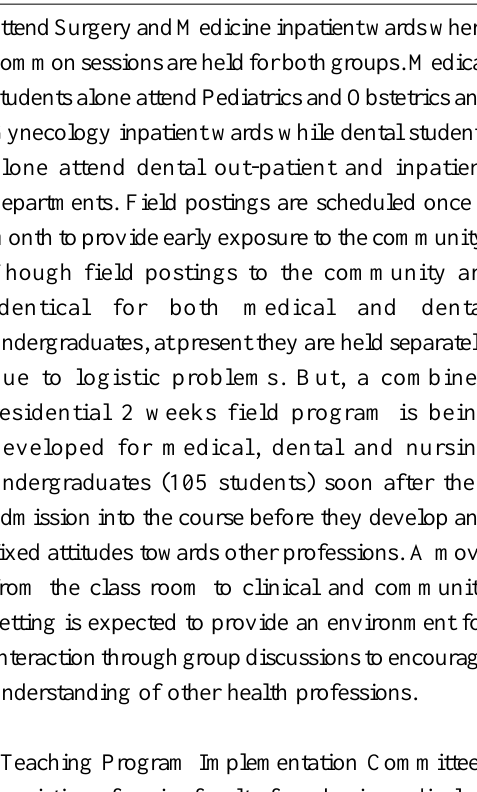
Table I : Organisation of basic